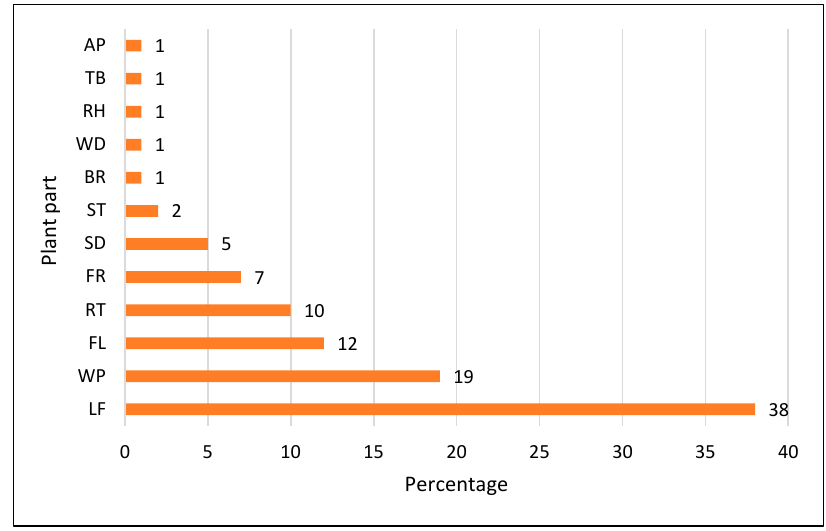
Figure 4. Percentage contribution of plant part used.